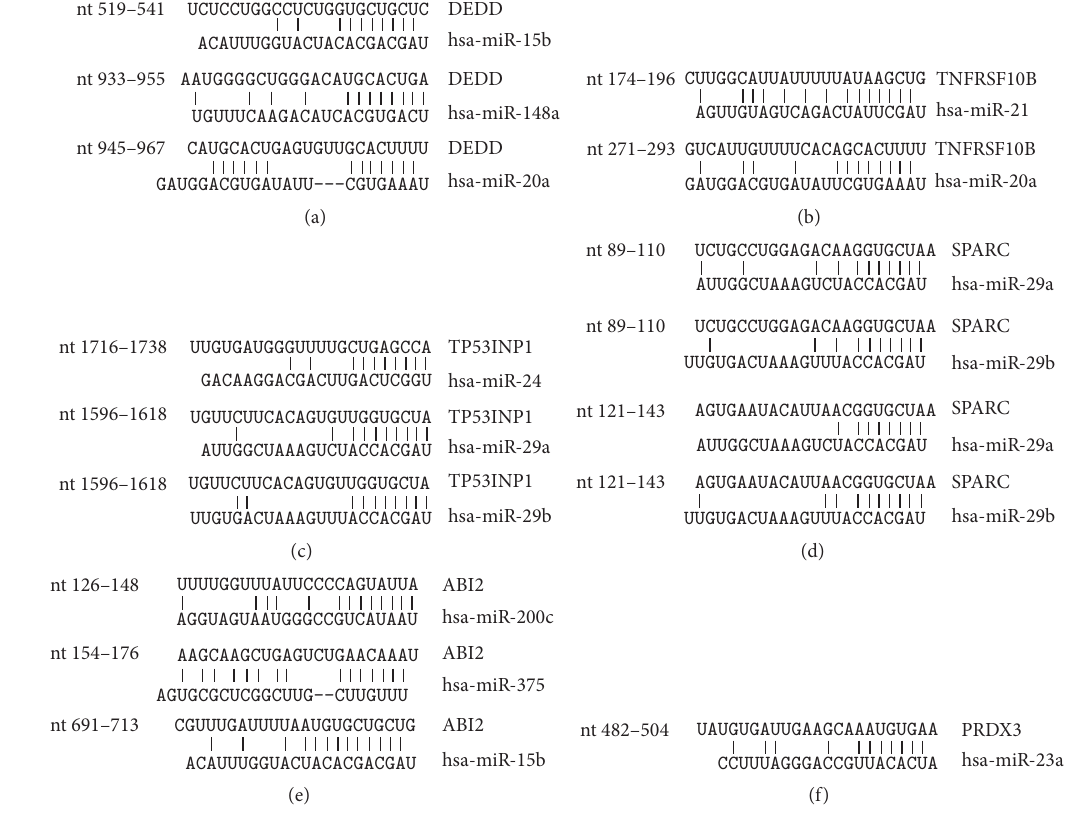
Figure 2: Predicted miRNA target sites in 3 󸀠 UTRs. The 3 󸀠 UTR regions of DEDD (a), TNFRSF10B (b), TP53INP1 (c), SPARC (d), ABI2 (e), and PRDX3 (f) are depicted. A schematic representation of the predicted miRNAs and their interaction site(s) is